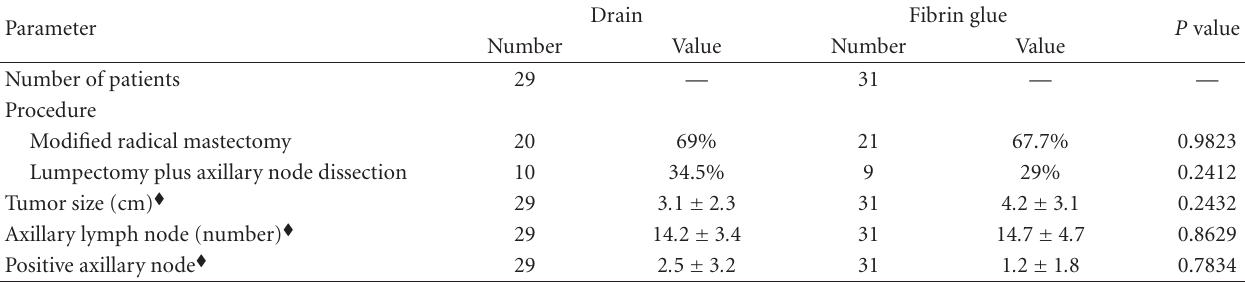
Table 2: Comparison of performed, tumor size, and axillary lymph node sampling for the drain and fibrin glue groups.